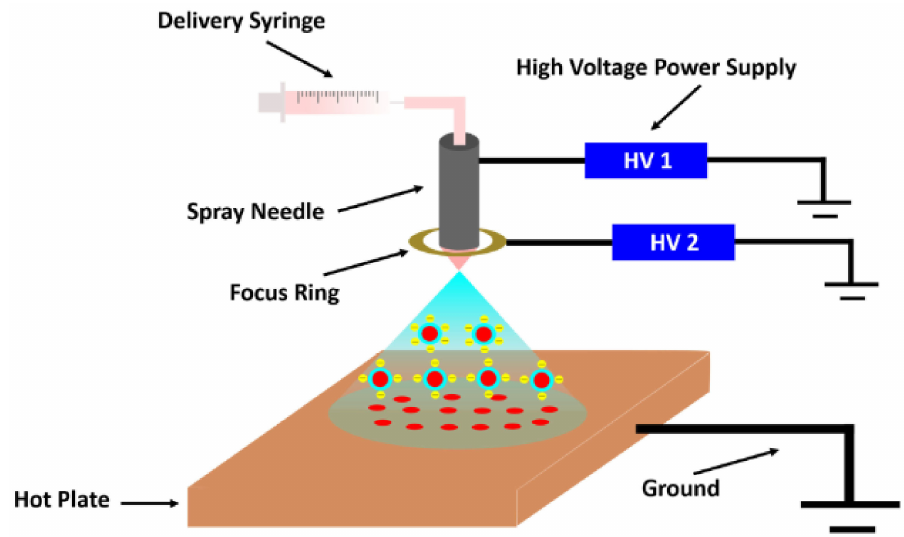
Figure 7. Deposition of chitosan via electrospraying method. Reprinted from [19]. Copyright 2022 with permission from the American Chemical Society.